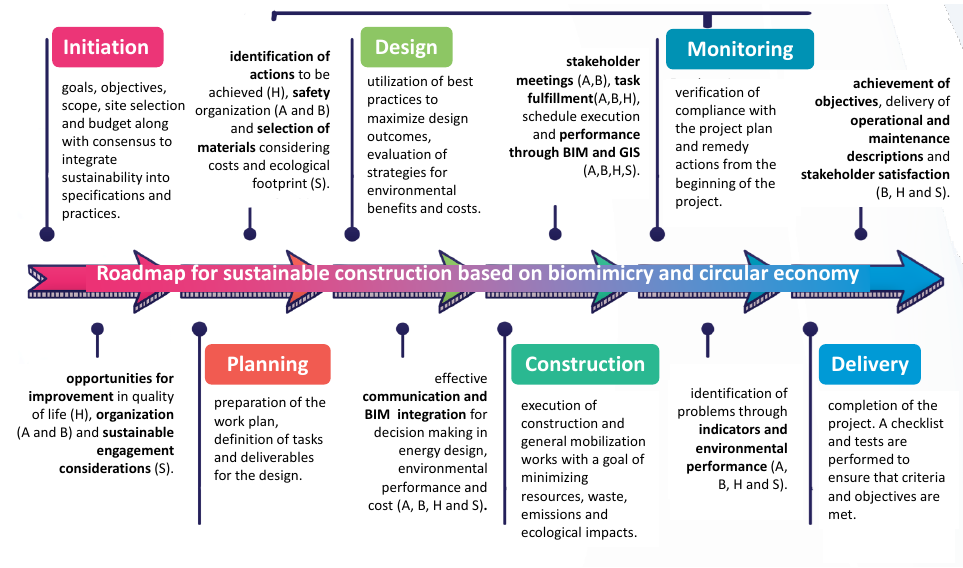
Figure 14. Summary of the road map phases definition with the accounting for the biocircular model approach.